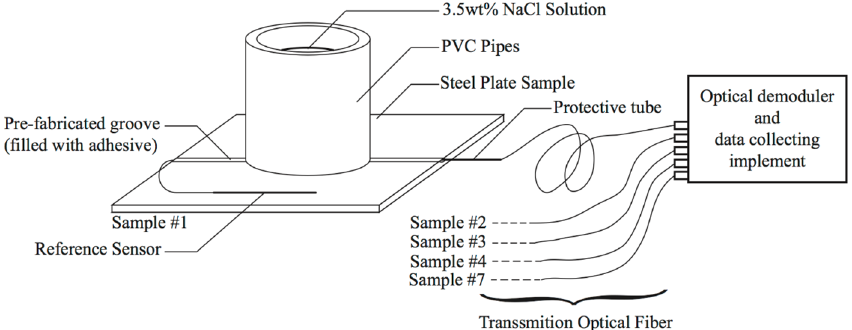
Figure 11. Accelerated corrosion test set ‐ up.